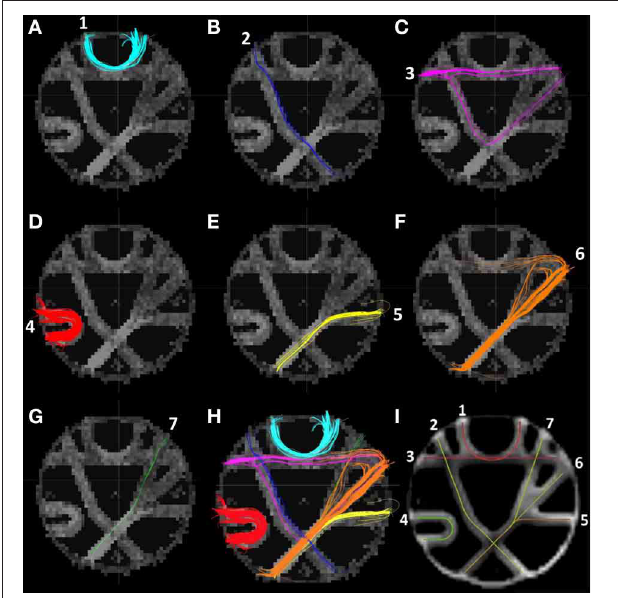
FIGURE 8 | (A) Enumerated ground truth fibers in the MICCAI 2009 Fiber Cup phantom dataset. (B) Results obtained comparing the different methods Spline , DTKODF , and DTKTensor with the ground truth. (C) Results obtained comparing Spline with varying step-length h (1, 1 . 5, and 2mm). The phantom dataset contains 16 ROIs, and the fibers intersecting each of these ROIs constitute fiber bundle 1–16. For the comparison, the average spatial metric using 1000 points were employed (computed with interpolating splines). The lower the metric value, the closer the tracking is to ground truth.